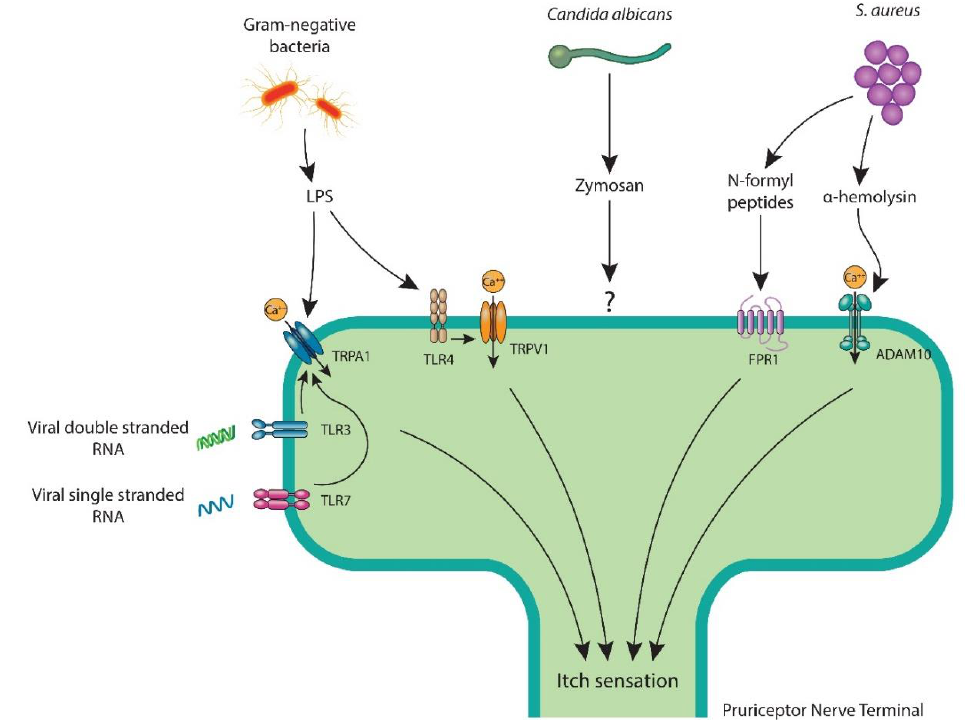
Figure 2. Pruriceptor neurons recognize skin pathogens and their molecular ligands by various mechanisms to facilitate itch. LPS, a key cell wall component of Gram-negative bacteria attaches to neuronal TLR4 and primes TRPV1 ion channel or opens the TRPA1 ion channel. S. aureus triggers itch with bacterial N-formyl peptides that bind to FPR1 or via α -hemolysin, which couples with ADAM10. C. albicans stimulates pruriceptors with its cell wall component zymosan. Viral double-strand RNA and single-strand RNA bind to TLR3 and TLR7, respectively, which are believed to sensitize the TRPA1 ion channel. ADAM10: a disintegrin and metalloproteinase domain-containing protein 10; FPR1: formyl peptide receptor 1; LPS: lipopolysaccharide; RNA: ribonucleic acid; TLR: Toll-like receptor; TRPA1: transient receptor potential ankyrin 1; TRPV1: transient receptor potential vanilloid